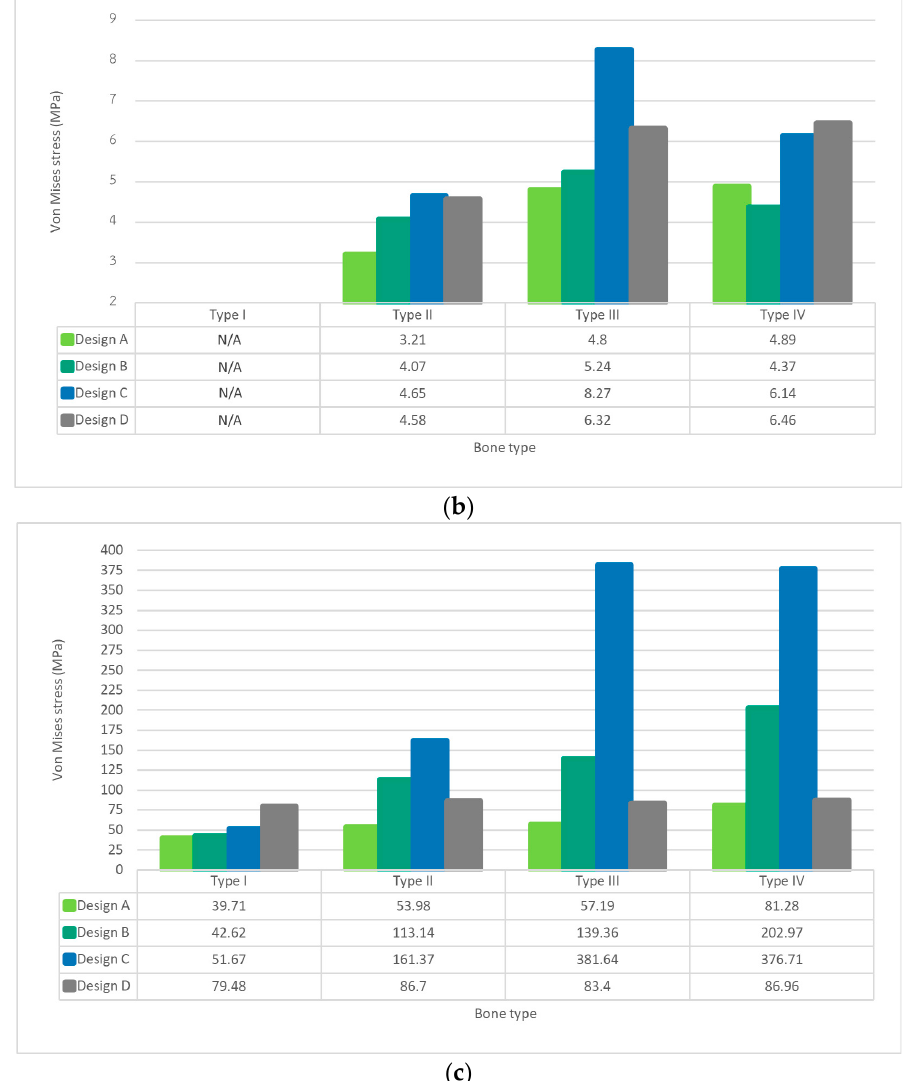
Figure 3. Bar chart of von Mises stress in all models; ( a ) von Mises stress in cortical bone; ( b )von Mises stress in cancellous bone; ( c ) von Mises stress in implant.